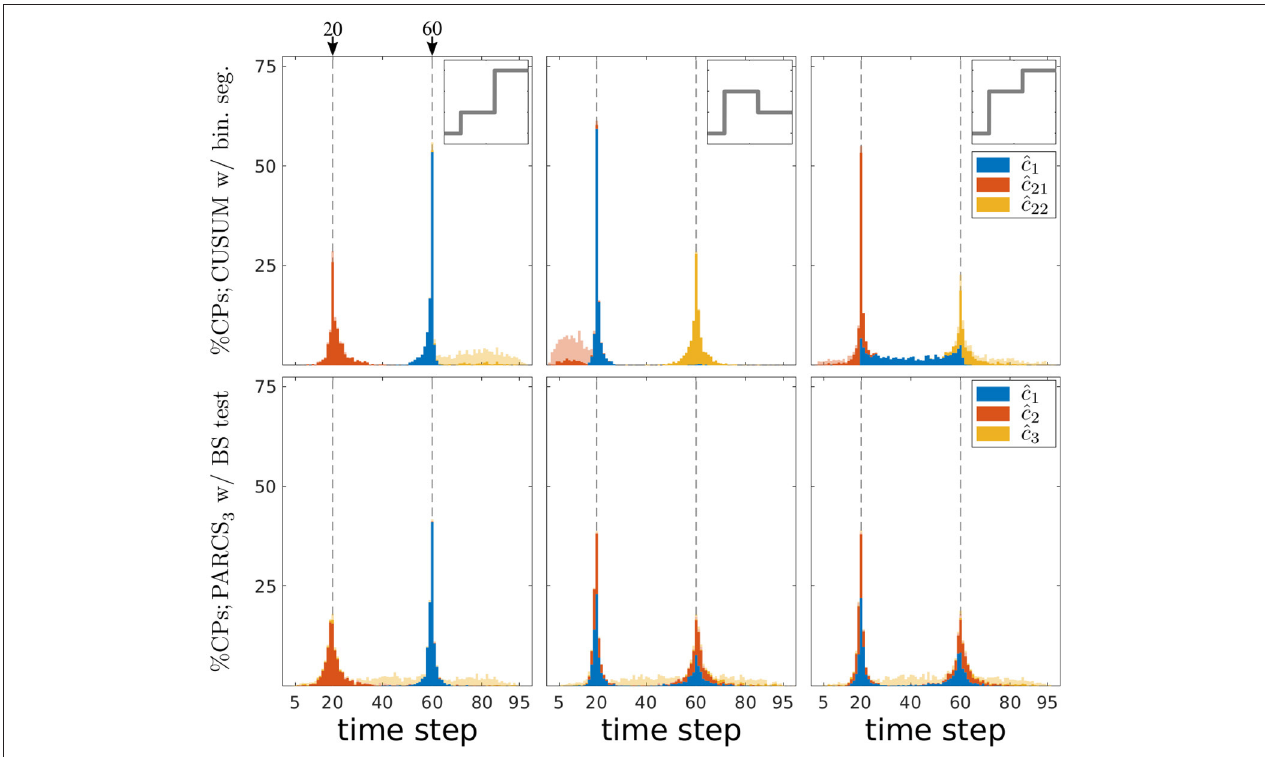
FIGURE 5 | Comparing PARCS to CUSUM with binary segmentation for multiple CP detection; stacked histograms of correct detection rates for CUSUM’s ˆ c 1 , ˆ c 21 , ˆ c 22 (top) and PARCS’ ˆ c 1 , ˆ c 2 , ˆ c 3 (bottom) over 1,000 realizations; transparent bars show candidate CPs excluded by the permutation test; dashed gray, ground truth CPs; top inset, deterministic component of time series for the respective column’s scenario; left, center, and right refer to first, second, and third scenario, respectively.